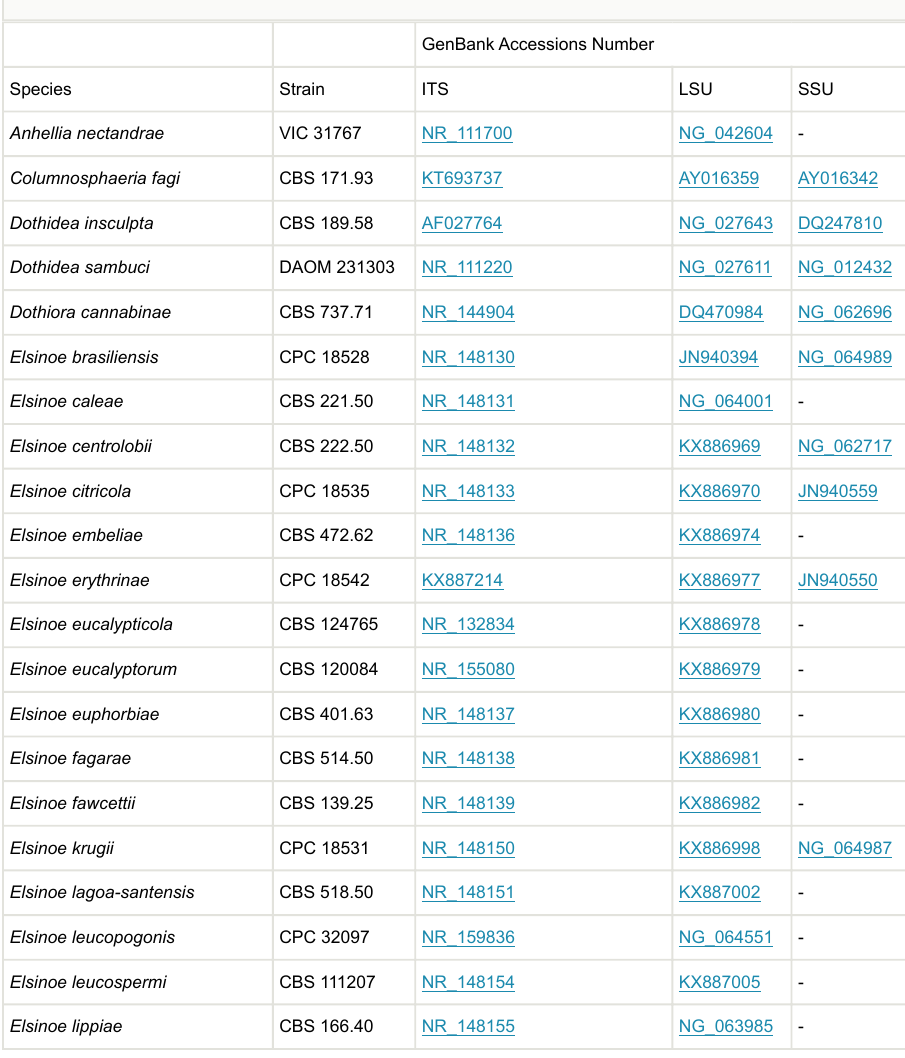
th for 5,000,000 generations and the trees were sampled every 100 generation. The first 10% of trees that represented the burn-in phase were discarded and only the remaining 90% of trees were used for calculating posterior probabilities (PP) for the majority rule consensus tree. The resulting trees were visualised in FigTree v.1.4.0 converted to a jpeg file using Adobe Photoshop CS6 (Adobe Systems, USA).